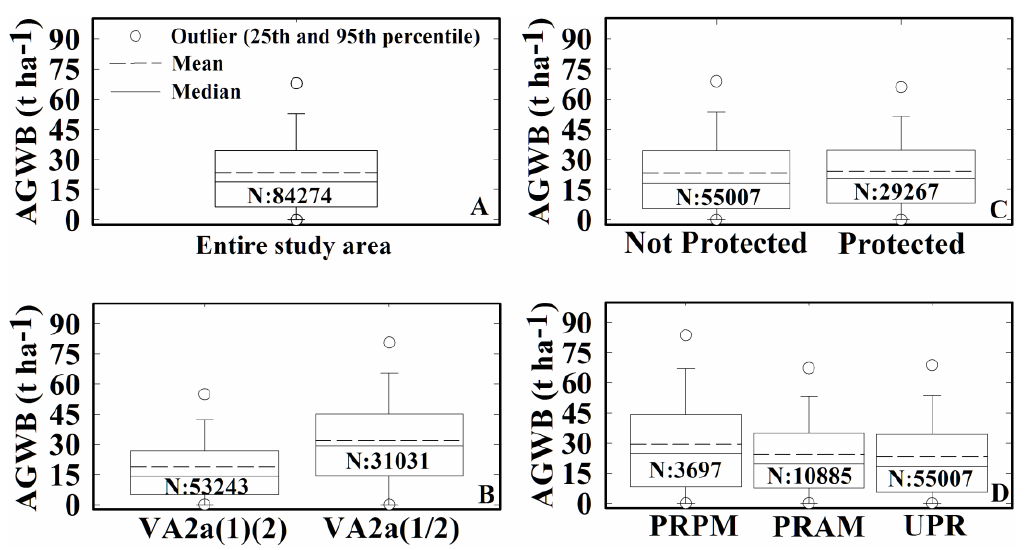
Figure 6. ALOS PALSAR-derived AGWB ha −1 estimates for ( A ) the study area (933 km 2 ), ( B ) the two UNESCO savanna land cover classes, ( C ) protected versus unprotected areas and ( D ) the protected areas with active management (PRAM), passive management (PRPM) and unprotected areas (UPR); in each case, N represents the number of pixels (104 m ×104 m) from the biomass map falling within each of the